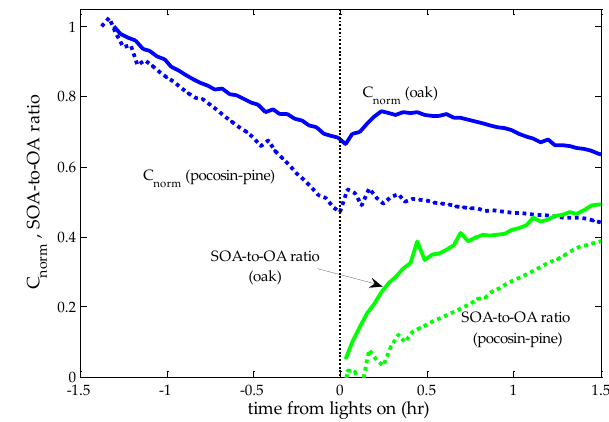
Fig. 4. Time series of OA concentrations normalized by initial con- centrations, and SOA formation rate upon